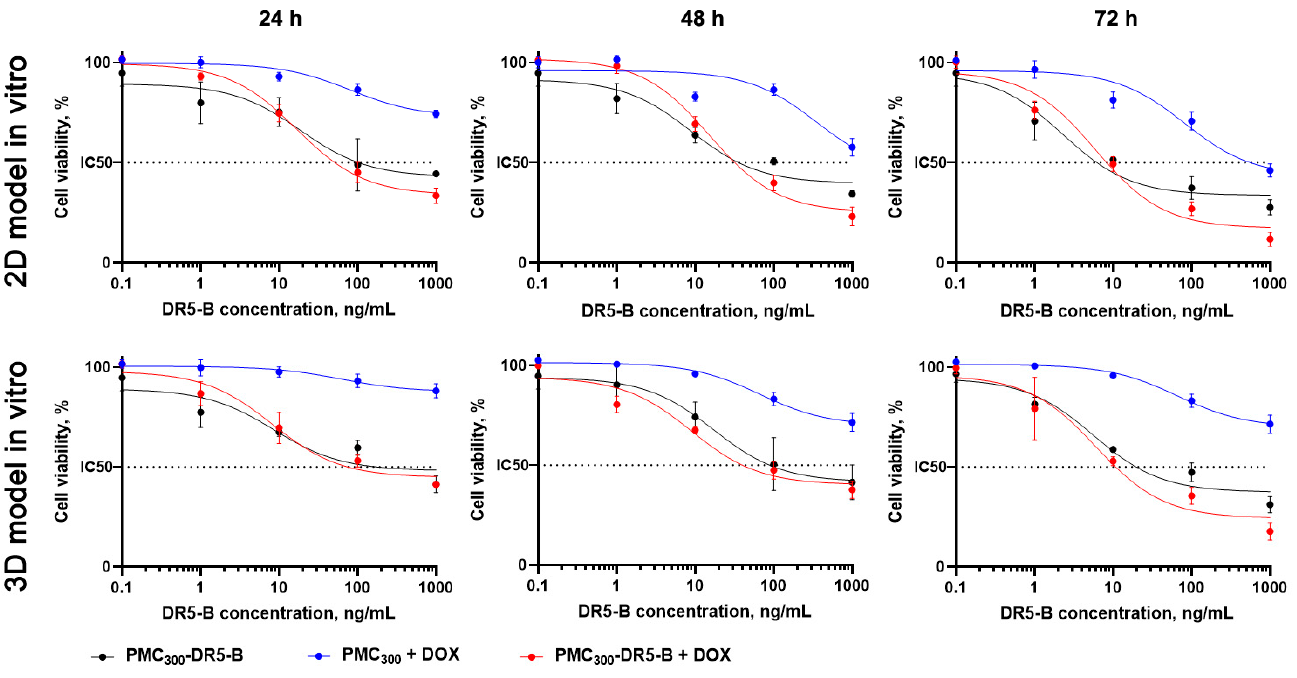
Figure 9. The cytotoxicity effects of the capsules modified with DR5-B (PMC 300 -DR5-B), the DOX-loaded capsules (PMC 300 + DOX) and the DOX-loaded capsules modified with DR5-B (PMC 300 -DR5-B + DOX) on human colorectal carcinoma HCT-116 cells after 24, 48 and 72 h incubation. Monolayer cell culture (a top panel) and the tumor spheroids (a lower panel). MTT-test. p < 0.05 indicates significant difference according to Student’s t-test. Table 2. The IC50 values of the capsules on human colorectal carcinoma HCT-116 cells. Monolayer cell culture (2D in vitro model) and tumor spheroids (3D in vitro model). Free DR5-B protein, free DOX and the combination of free DR5-B with free DOX were taken as controls. MTT-test.